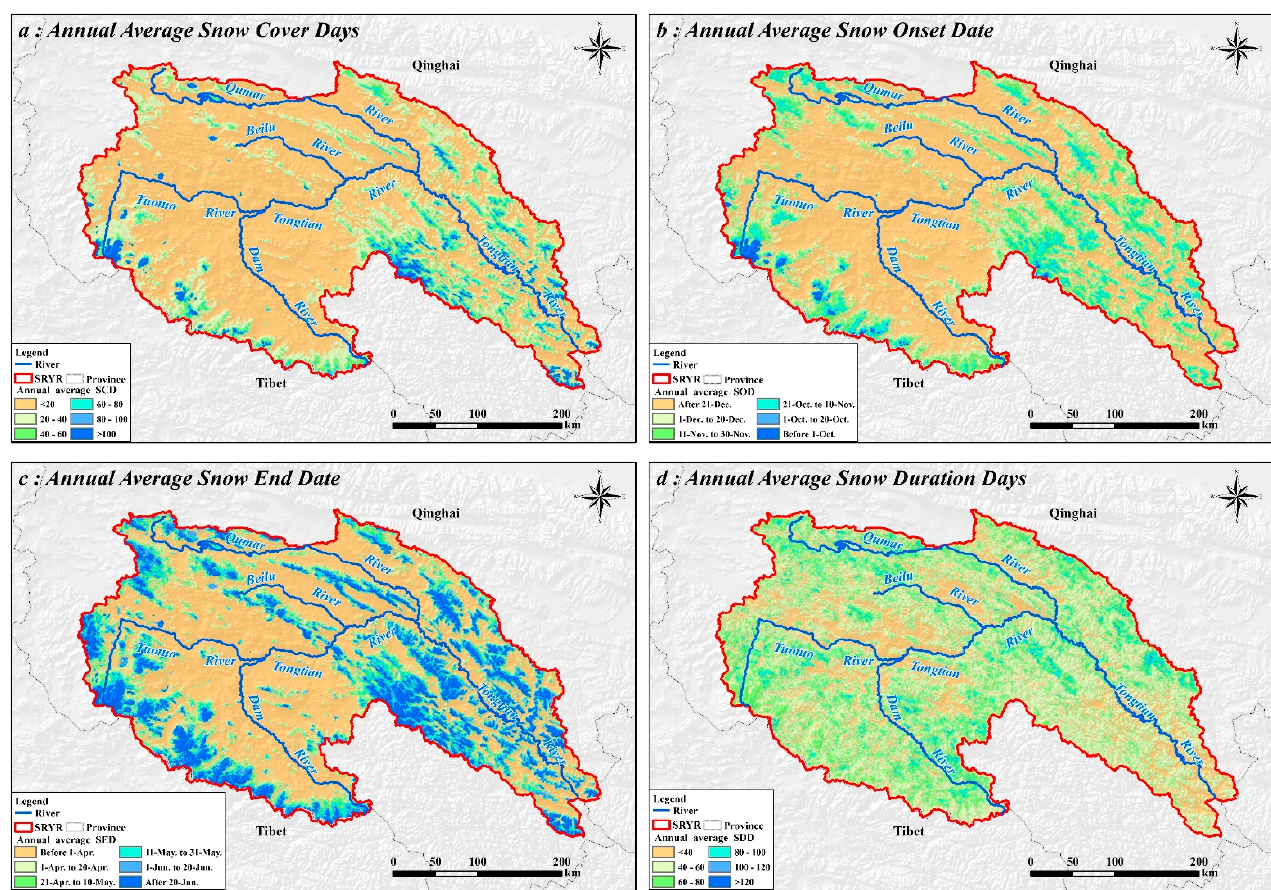
Figure 5. Spatial distribution of snow cover phenology: (( a ): SCD; ( b ): SOD; ( c ): SED; ( d ): SDD). The spatial distribution of SOD, SED, and SDD of SRYR in recent years is shown in In this paper, the trends of three snow phenology (SOD, SED, and SDD) in the